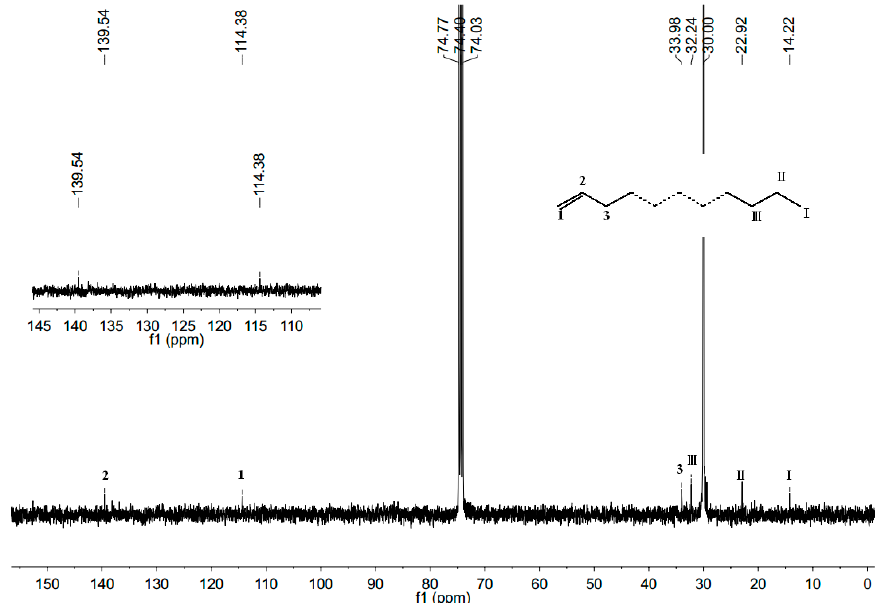
Figure 6. 13 C ‐ NMR spectrum of the polyethylene obtained using Co2 /MAO at 50 °C (run 9, Table 2); recorded in 1,1,2,2 ‐ tetrachloroethane ‐ d 2 at 120 °C.